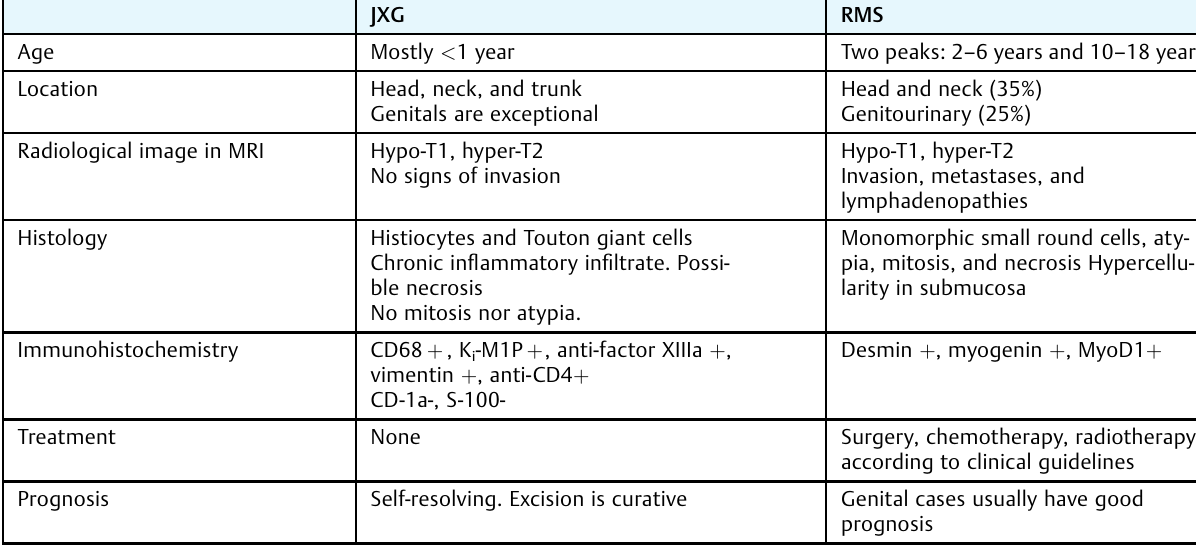
Table 1 Differential diagnosis between JXG and RMS